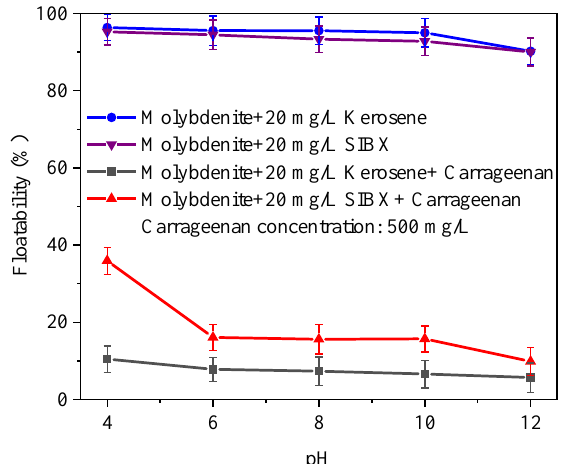
Figure 3. Floatability of molybdenite as a function of pH.